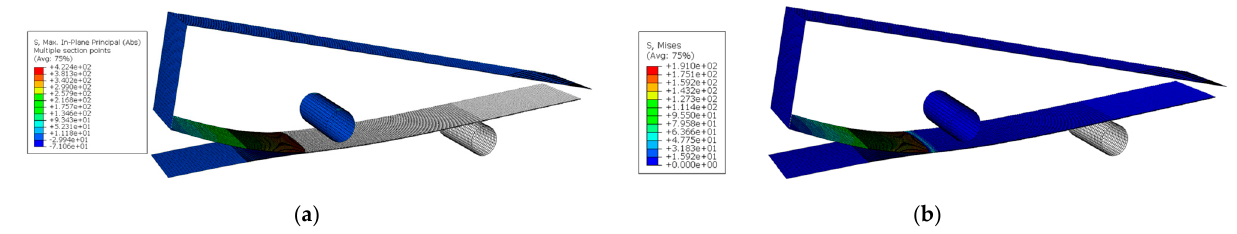
Figure 17. Fracture cross-section of Mixed-mode analysis results: ( a ) in-plane stress contour and ( b ) von Mises contour.